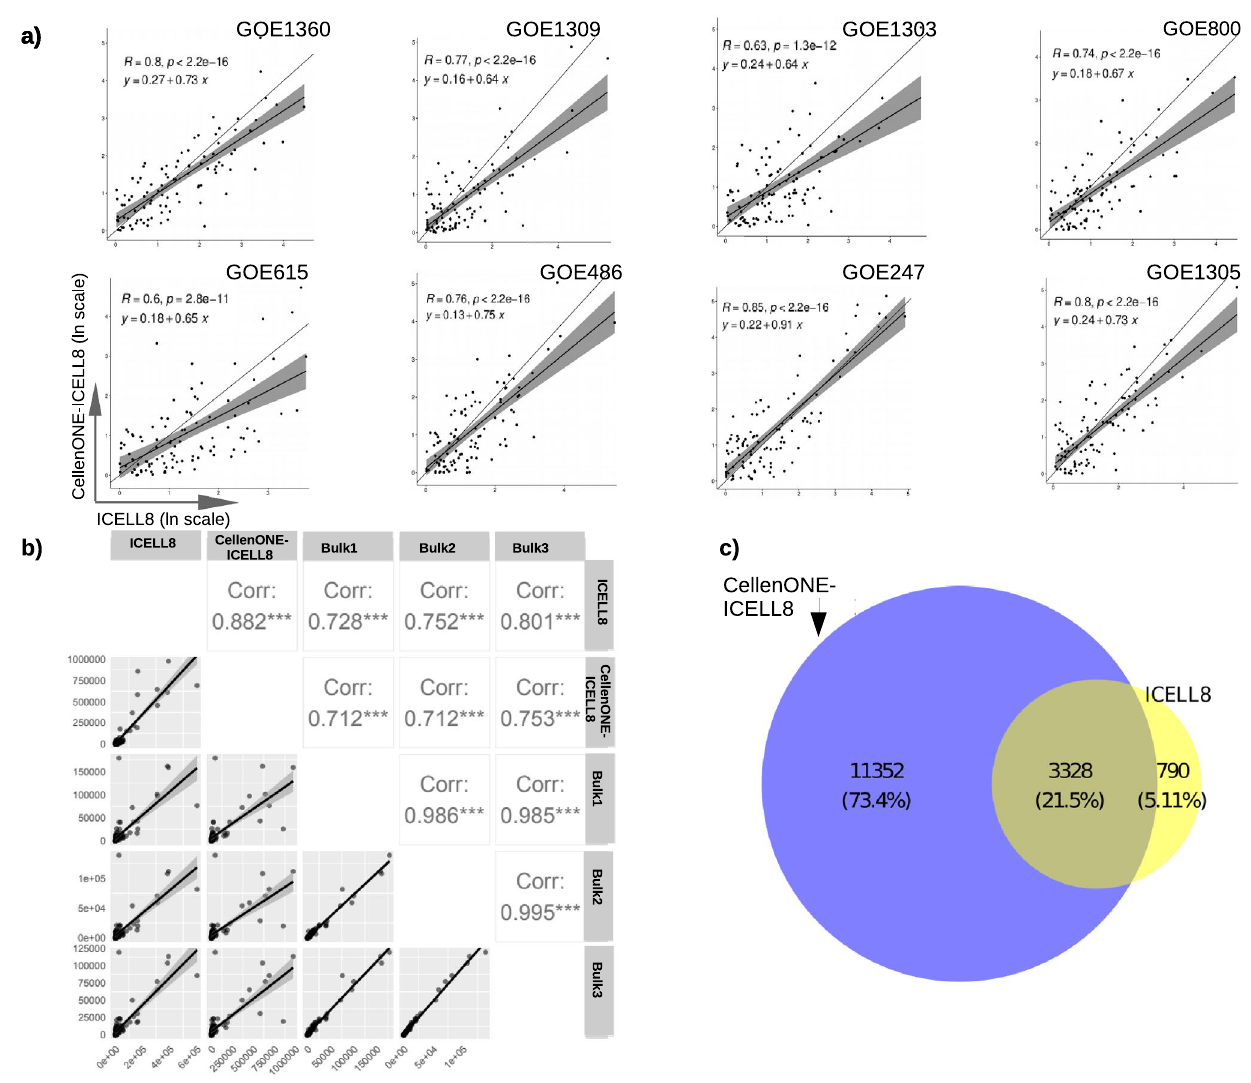
Figure 3. Correlations of scRNA-Seq methods and bulk RNA-seq. ( a ) Natural-log-scaled ranks of top 100 markers in each sample from both single-cell approaches, including a regression line with 95% confidence interval (in gray) and the overall correlation coefficient R. ( b ) Correlations of normalised expressions of the top 100 markers in sample GOE247 between both single-cell and bulk RNA-seq, with the correlation coefficients indicated in the upper triangle. ( c ) Venn diagram of all markers detected for sample GOE247 in both